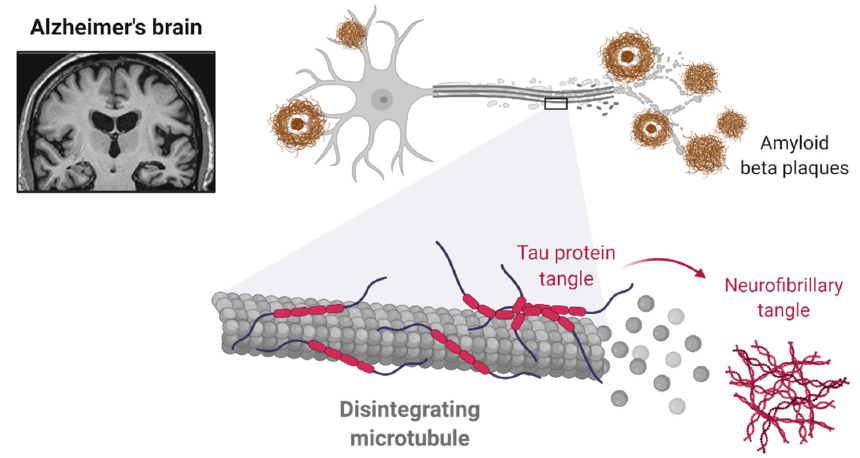
Figure 1. The hallmarks of AD are the presence of a A β plaques and neurofibrillary tangles.